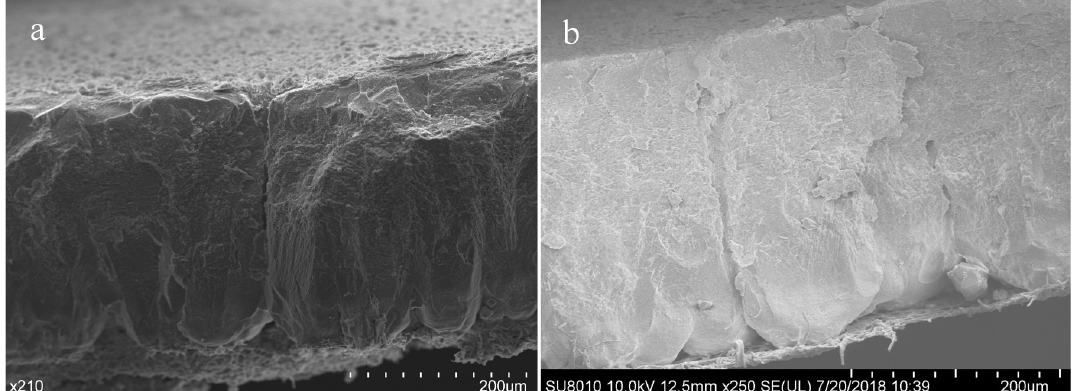
Fig 3. (a) Exposed and (b) unexposed pores on the eggshell surface. Pores are the pathway for vapor exchange and invasion of microbes. Cuticles cover the outer pore orifice and form a barrier against bacterial trans-shell